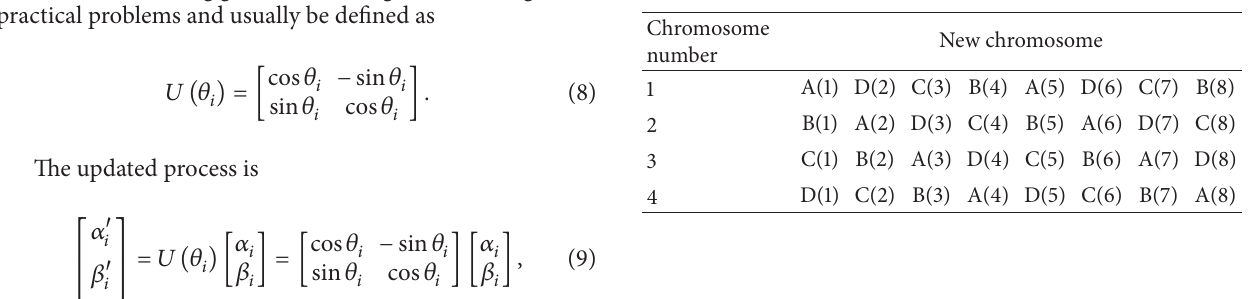
Table 3: One result of the whole interference